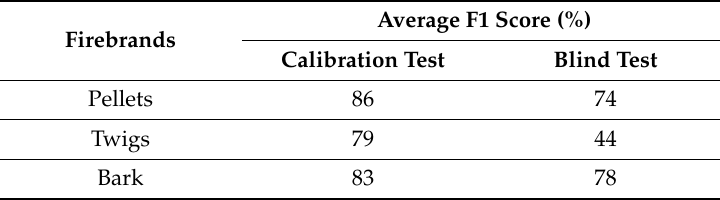
Table 3. The DoG algorithm average accuracy using blind